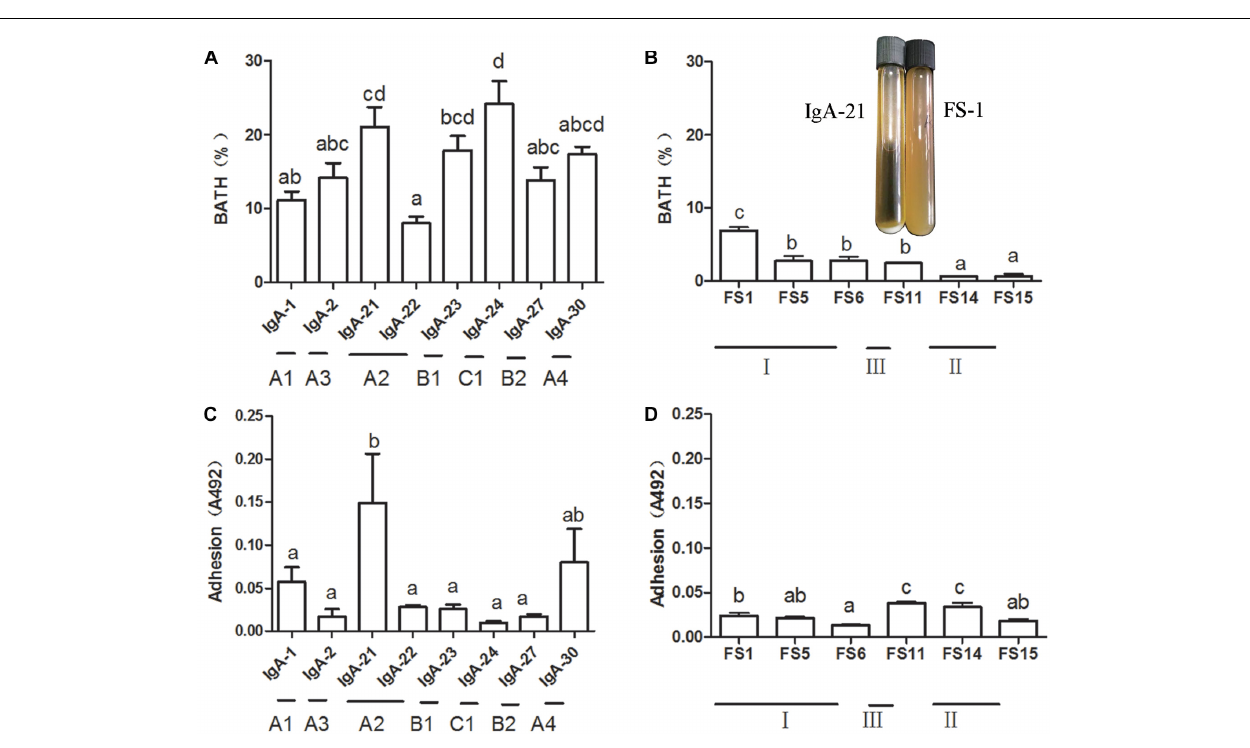
higher from that of the normal diet fed group ( P <